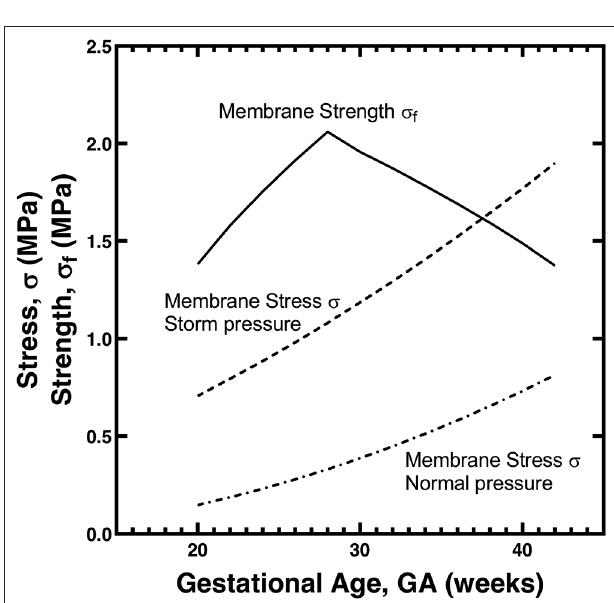
FIGURE 2 | Model for CA membrane stress σ and strength σ f as a function of gestational age GA . The strength values are calculated from the data in Figure 1 using Equation (1); the stress values for normal and storm atmospheric pressures are calculated from Equation (2) with parameter values as described in the